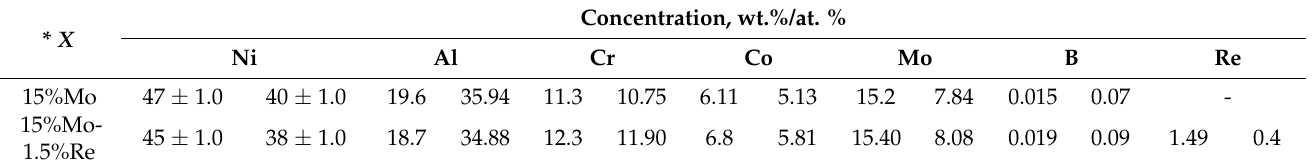
Table 6. Elemental composition of the NiAl–Cr–Co+15%Mo and NiAl–Cr–Co+15%Mo+1.5%Re alloys.